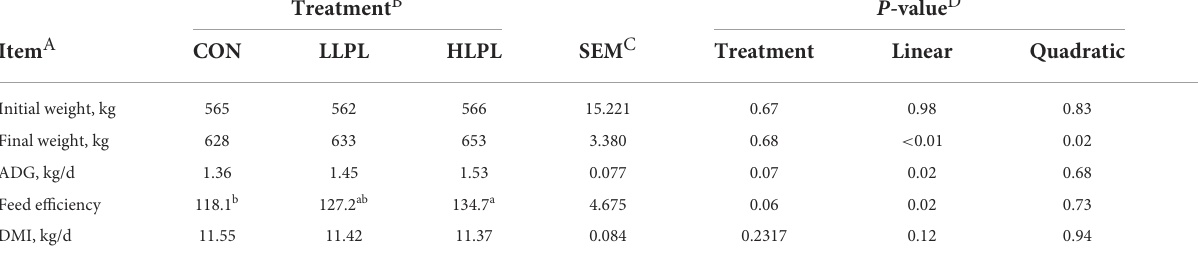
TABLE 2 Effect of dietary lysophospholipids supplementation on growth performance of beef cattle. Treatment